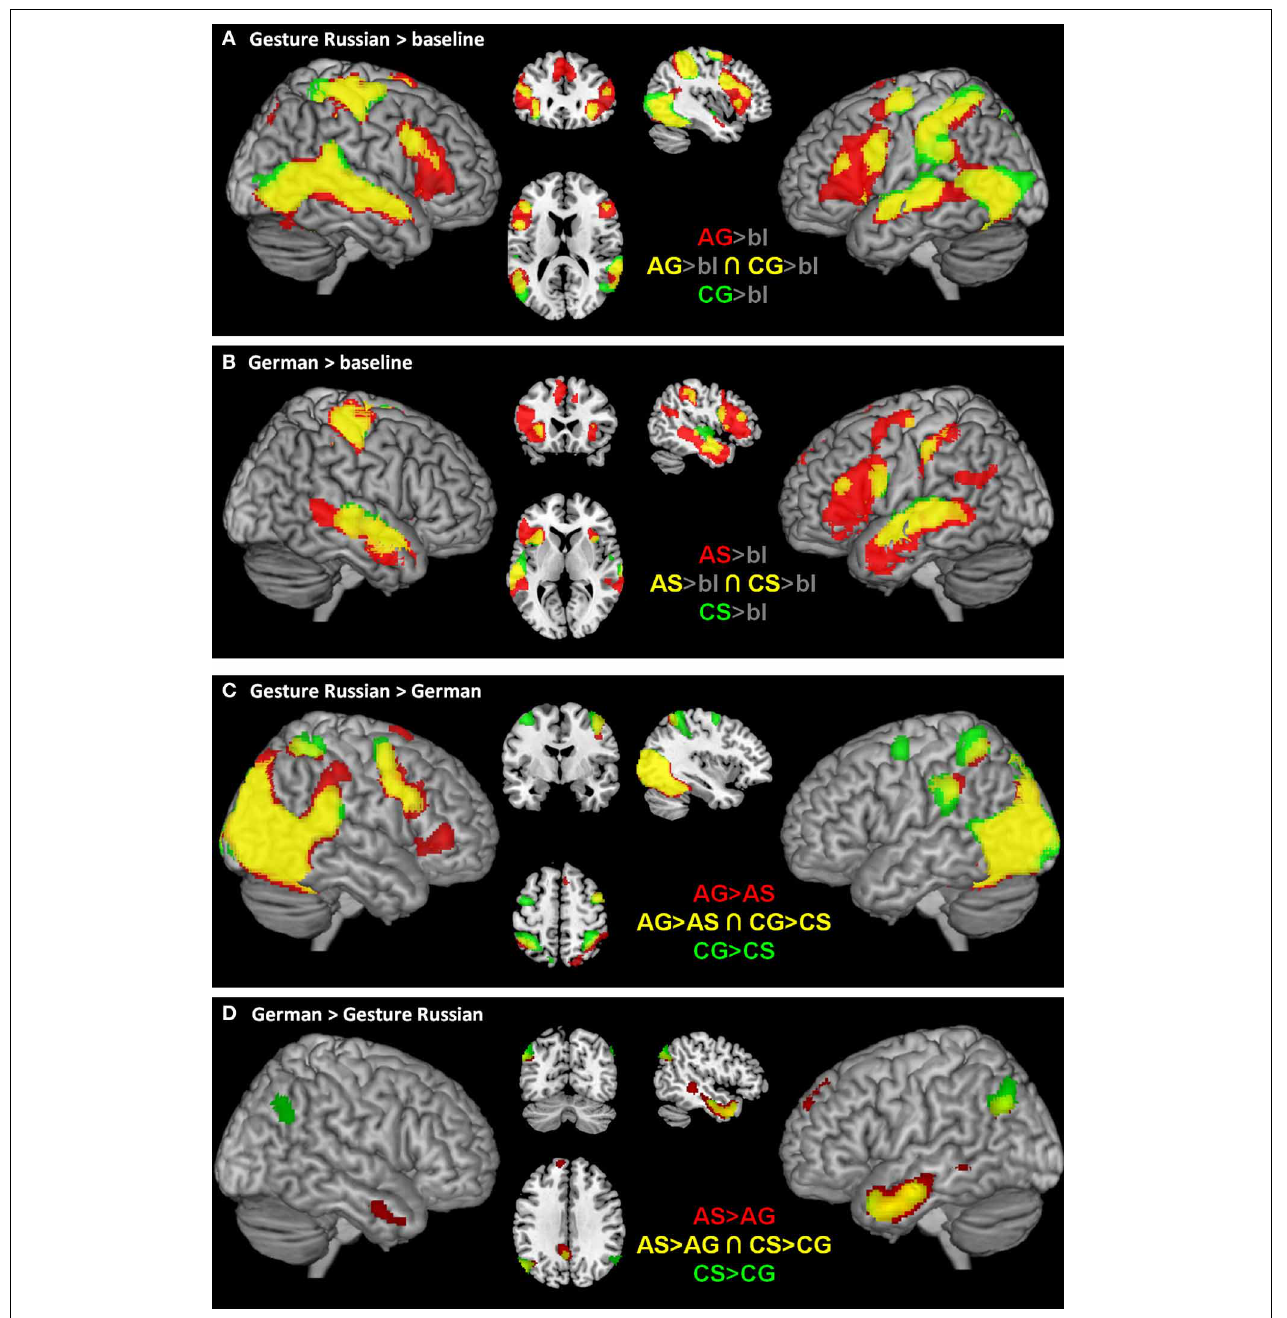
FIGURE 3 | Illustrates the fMRI results for abstract semantics (red), concrete semantics (green), and common neural structures (yellow) for each condition in contrast to low-level baseline (gray background; A, Gesture; B, German), for gesture conditions in